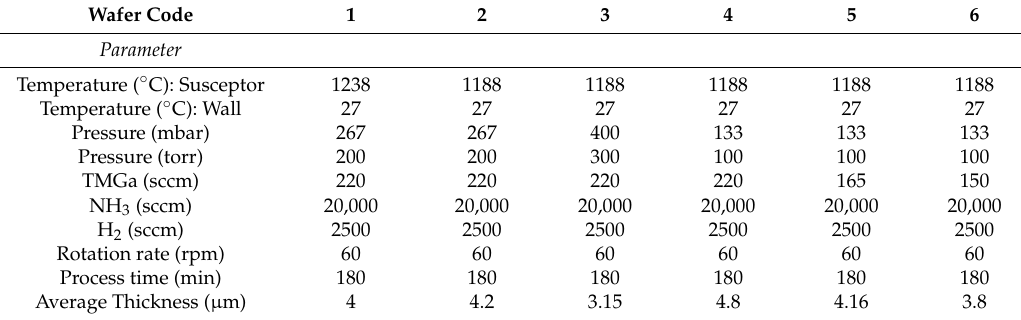
Table 1. Parameters of the epitaxy experiment set.